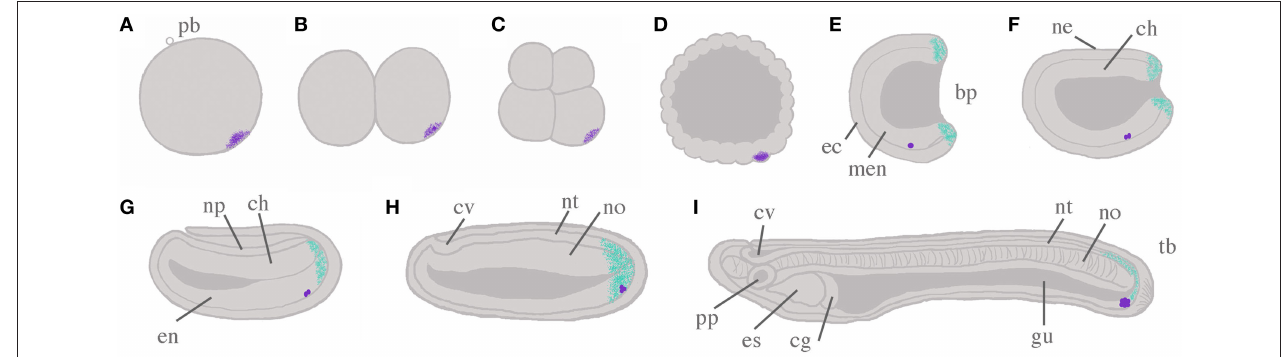
FIGURE 1 | Schema of amphioxus embryogenesis, with hypothesized scenario for germ cell development. The germ plasm and Primitive Germ Cells (PGCs) are indicated by stippled violet and violet dots, respectively. Putative posterior somatic stem cell zones are indicated in cyan. (A) Fertilized egg: the polar body (pb) indicates the animal pole; (B) two cell stage; (C) eight cell stage; (D) blastula; (E) mid-gastrula: ectoderm (ec) and mesendoderm (men) are evident; (F) late gastrula/early neurula: dorsal ectoderm has become neurectoderm (ne), with chordomesoderm (ch) located ventrally in the midline; (G) mid-neurula: ectoderm has grown over the neural plate (np); (H) late neurula: both neural tube (nt) and cerebral vesicle (cv) can be distinguished, as well as notochord (no) and paraxial somites (not shown); (I) pre-mouth stage larva: the notochord has begun to differentiate to form the characteristic “stacked coin” structure. A through-gut (gu) begins to form, and asymmetry becomes apparent with preoral pit (pp) and endostyle (es) on the left side, and club-shaped gland (cg) on the right. With the exception of (A–D) , all embryos are illustrated with dorsal upwards, and anterior to the left. All panels show sections through the midline only for simplicity, so somites and axial musculature, located either side of the midline, are by necessity omitted. Additional abbreviations are used to indicate the blastopore (bp), endoderm (en) and the tailbud (tb).